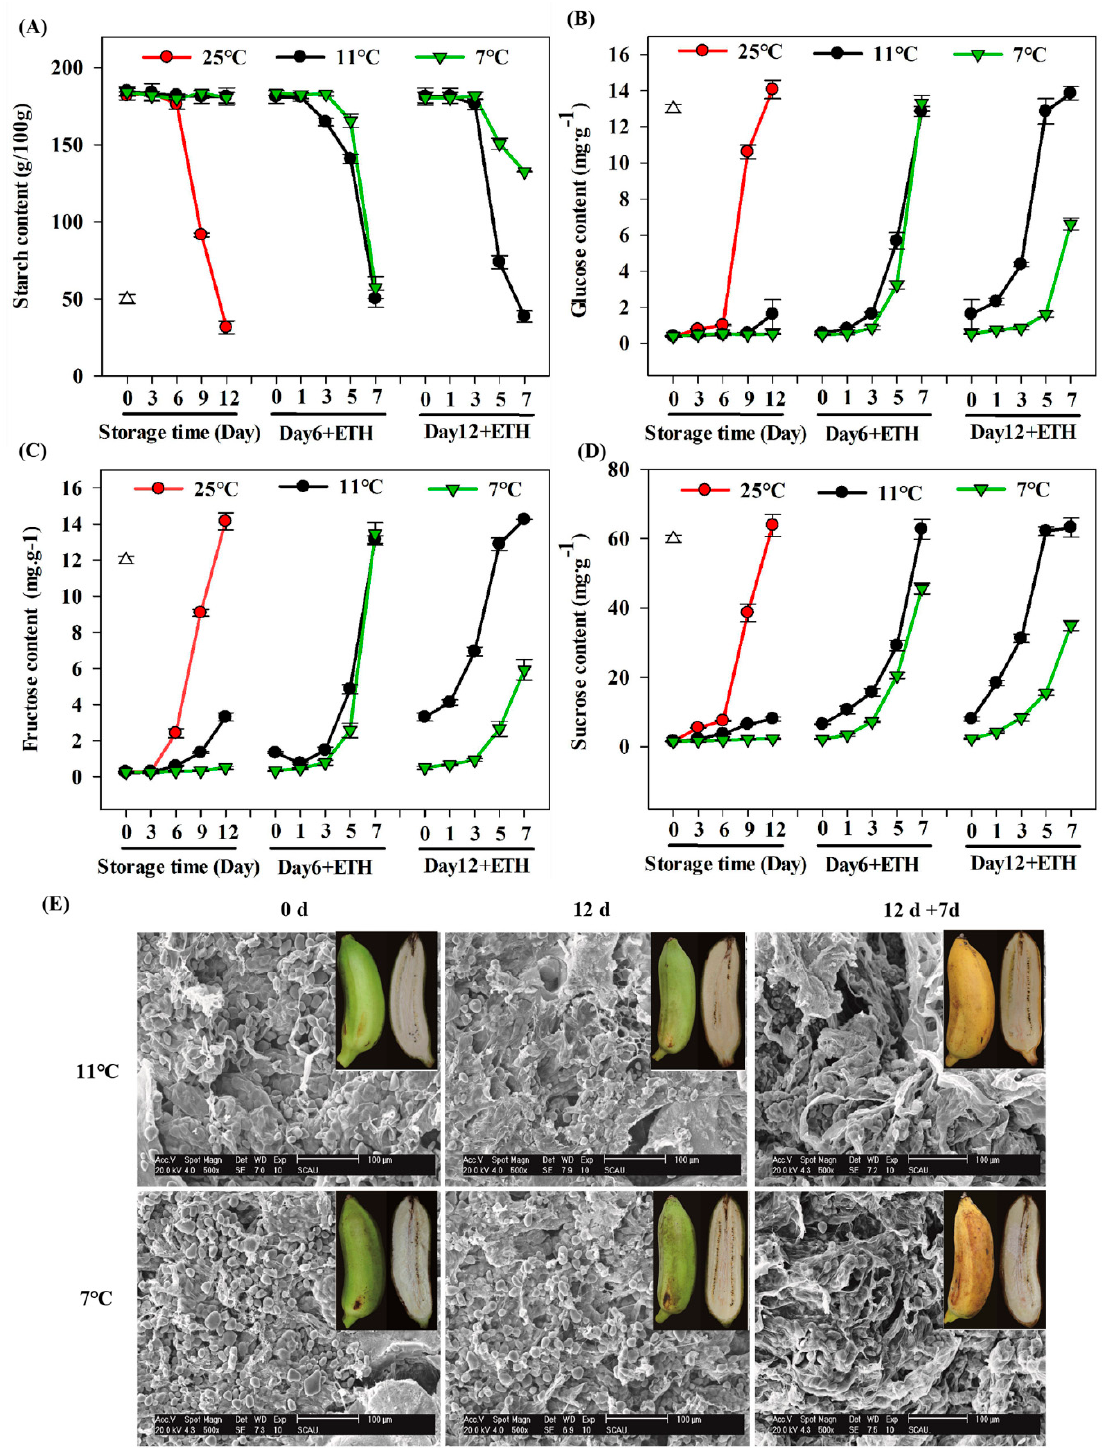
Figure 2. Changes in the content of: Starch ( A , E ), glucose ( B ), fructose ( C ), and sucrose ( D ) in banana fruit pulp during ripening. Fruit were stored at 25 °C, 11 °C, and 7 °C for 6 or 12 days, removed to 25 °C, and treated with ethephon. ( E ) Transmission electron microscopy pictures of Fenjiao fruit pulp close to core. Fruit pictured at harvest (0 d), after 12 days of cold storage, and at fully ripe stage following ethephon treatment.